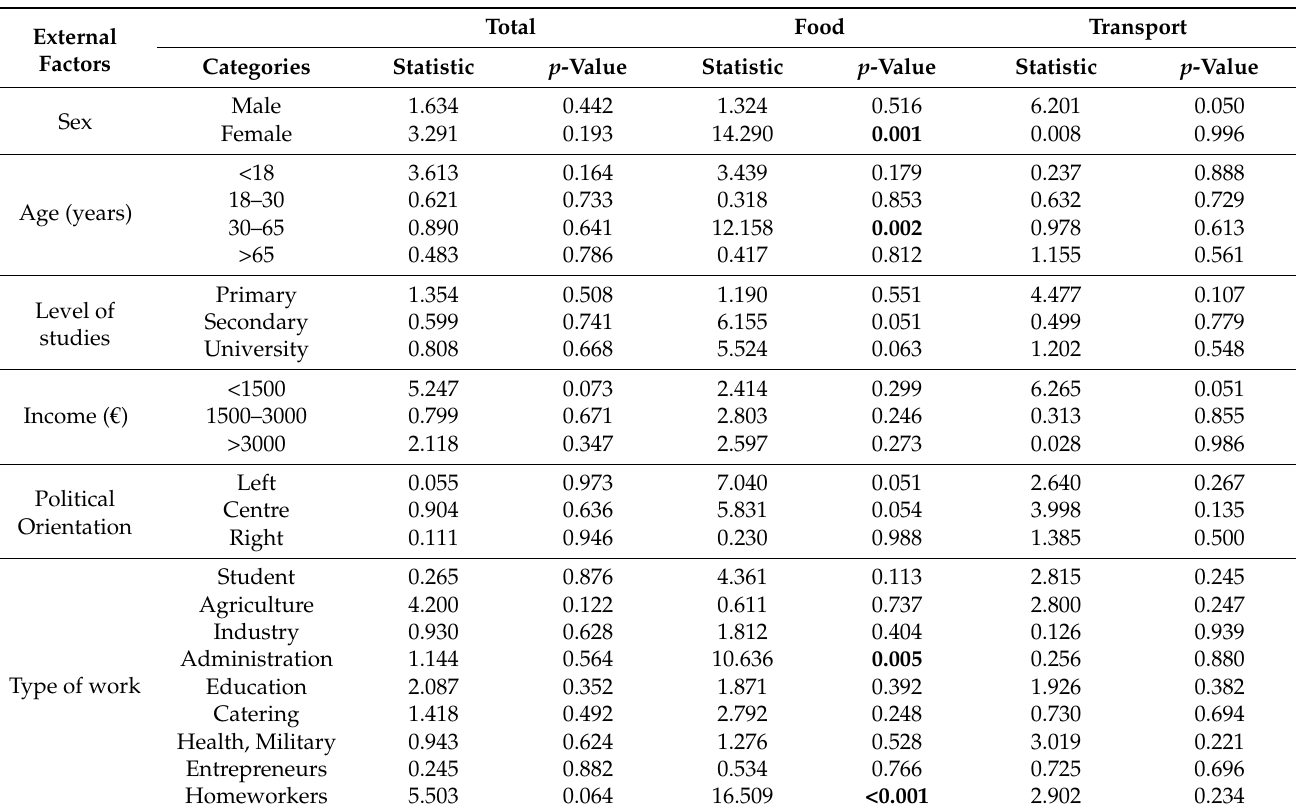
Table 3. Differences in personal CF across religious groups for each external